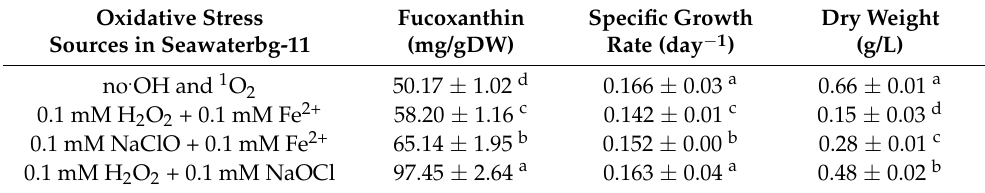
Table 4. Changes in biomass productivity of N. shiloi and variation in the fucoxanthin content under oxidative stress